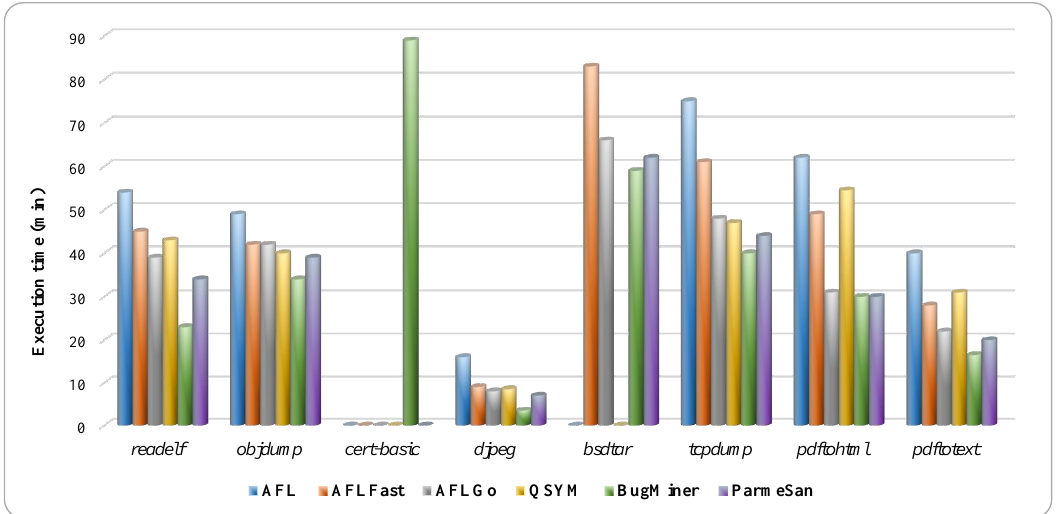
Figure 5. Evaluation results on eight real-world programs.